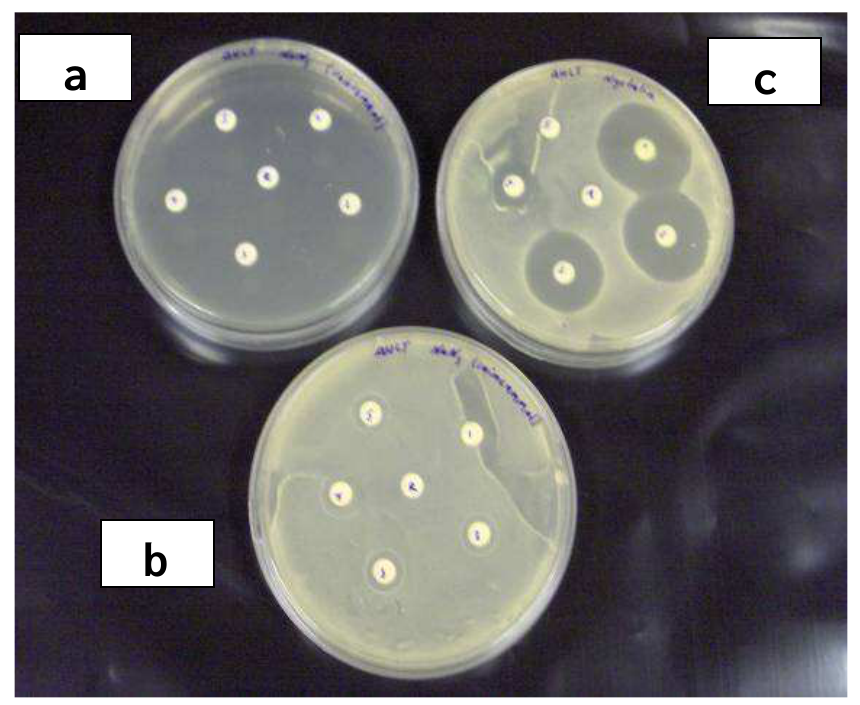
Figure 3. Toxicity assay on agar plates . A plate containing stronger sodium azide solution (a) has no visible growth, whereas in one containing more dilute sodium azide solutions (b) no clear inhibition circles are visible. A plate containing nystatin solutions (c) is a good example of toxicity assay with clear inhibition